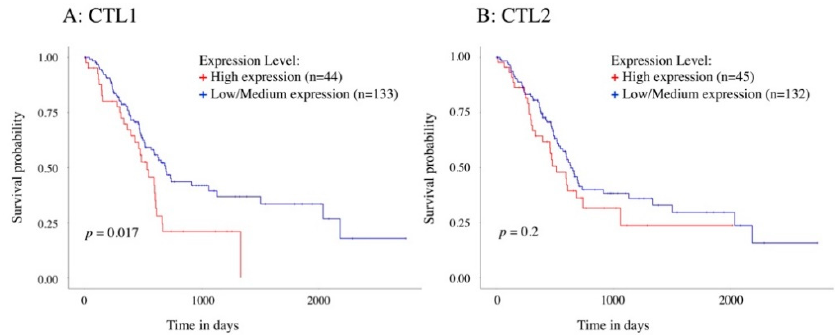
Figure 2. Bioinformatic analysis of association between CTL1 ( A ) and CTL2 ( B ) mRNA expression levels and survival in patients with pancreatic adenocarcinoma (PAAD). Kaplan–Meier plots summarize results from analysis of correlation between mRNA expression level and patient survival. Patients were classified as either high- or low- / medium-expression according to their expression level; x-axis, time of survival (days); y-axis, probability of survival, where 1.0 corresponds to 100%. The p -value was calculated using the log-rank test. For CTL1, the difference between the two curves was found to be statistically significant with p = 0.017, while for CTL2, the difference between the two curves was not significant ( p = 0.2).